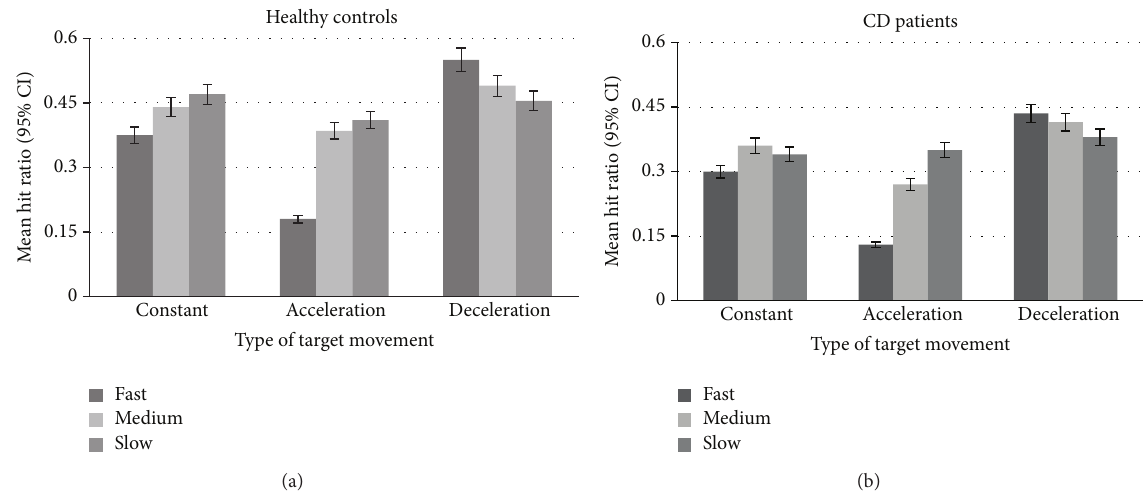
Figure 4: Mean hit ratio as a function of movement type and speed of the target in the main task.